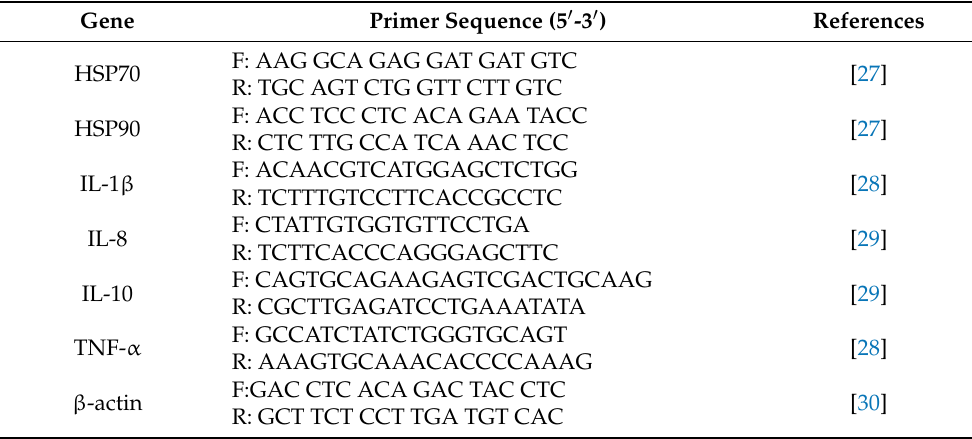
Table 3. List of heat shock protein and immune-relevant gene primers for qPCR analysis. Gene Primer Sequence (5 (cid:48) -3 (cid:48)